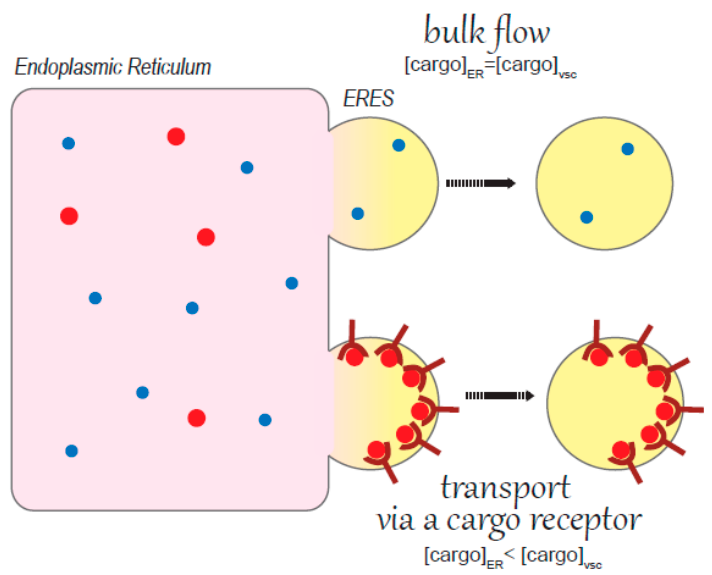
Figure 2. Mechanisms of exit from the ER. Proteins can be incorporated into vesicles departing from the ER simply by bulk flow or can be actively concentrated at the ERES by cargo receptors (active